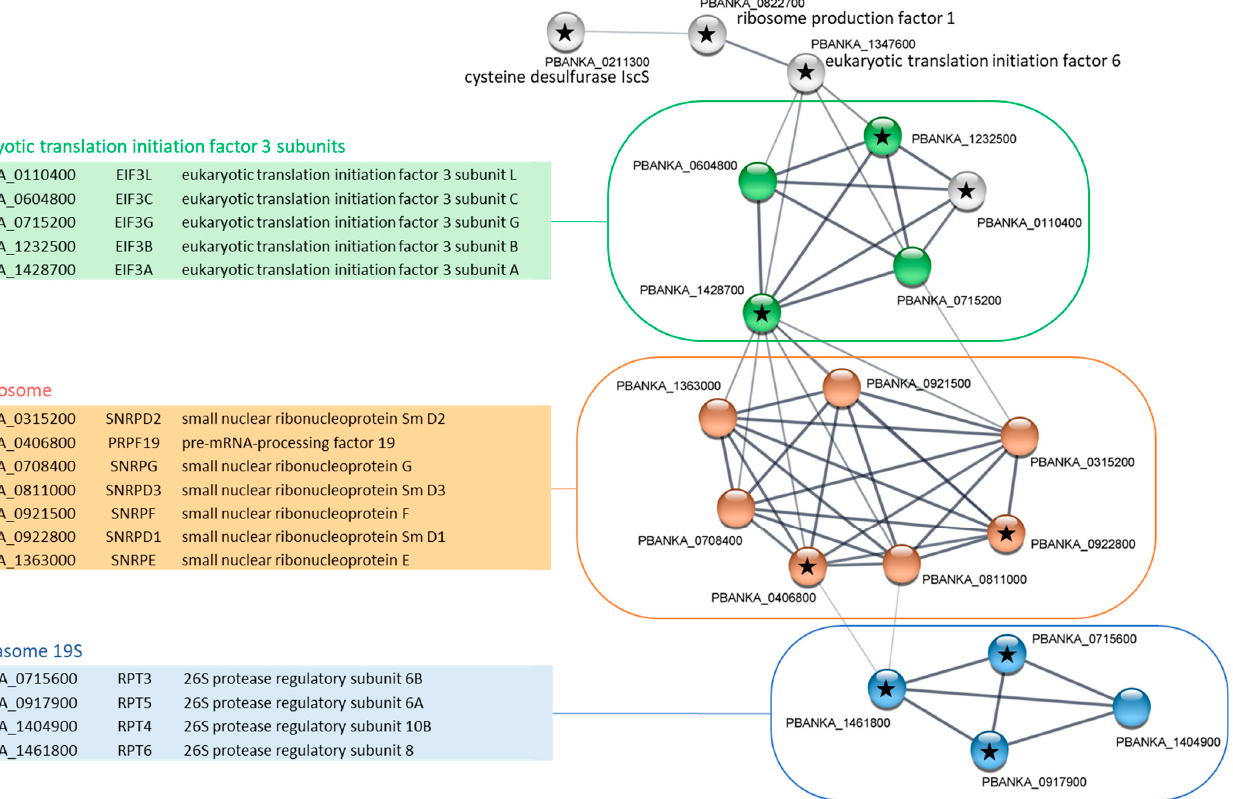
Figure 3. STRING network visualization of PbPP1c-interacting proteins belonging to “cellular component assembly” GO Slim in schizont stages. Using the Cytoscape STRING application, a network was retrieved for the 20 proteins from the cellular component assembly GO Slim of the PbPP1c interactome in schizont stages. With a protein–protein interaction enrichment p -value of 4.48 × 10 − 10 , the resulting network contained 53 functional associations among 19 proteins; one protein (PBANKA_126600, tubulin gamma chain, putative) with no associations to other proteins in the network was removed. Proteins from the KEGG pathways map03050 (Proteasome), map03013 (RNA transport), and map03040 (Spliceosome) are colored in blue, green, and orange, respectively. Assignation to Eukaryotic translation initiation 3 subunits was conducted manually based on the protein description in PlasmoDB. Black stars indicate proteins with RVxF motifs based on the Wakula consensus sequence [19]. Proteins in each network are listed in adjacent tables showing the PlasmoDB geneID, short name, and protein description. STRING analysis was performed using the 11.0b version of the software.